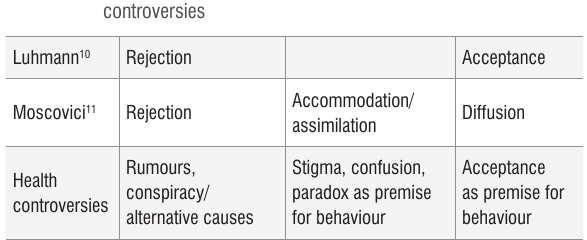
Table 1: Social representations theory: Luhmann, Moscovici and